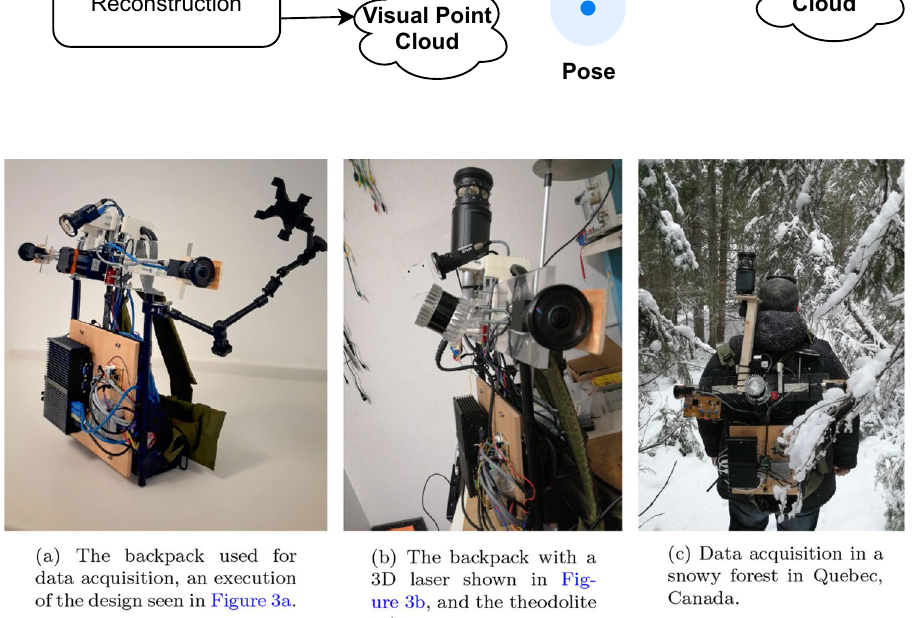
Fig. 2 Implementation of the design shown in Fig.